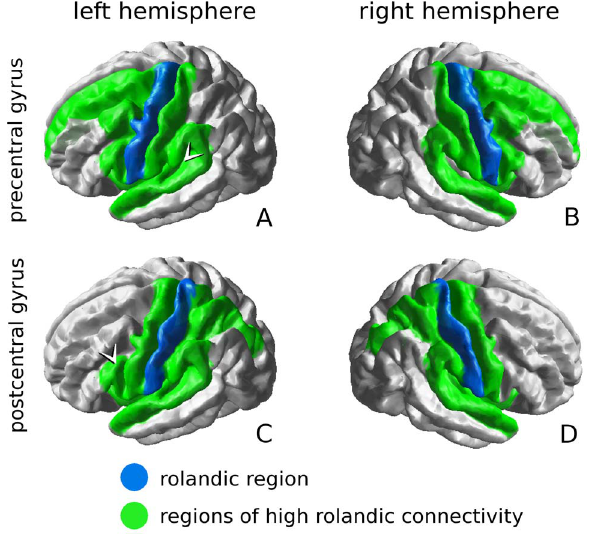
Figure 1. Rolandic connectivity profiles. The 10% most robust rolandic connections, for which the number of streamlines/voxel . 5. Averaged over all subjects, all 4 rolandic regions show high perisylvian connectivity, connecting strongly to the supramarginal and superior temporal gyri. Furthermore, the precentral gyri also strongly connect to prefrontal regions (A, B), whereas the postcentral gyri show strong connectivity with the superior parietal cortex. For the precentral gyri, the interhemispheric difference lies in the transverse temporal gyrus (arrowhead in A); for the postcentral gyri, the differences in connectivity lies in the pars opercularis of the inferior frontal gyrus (arrowhead in C).